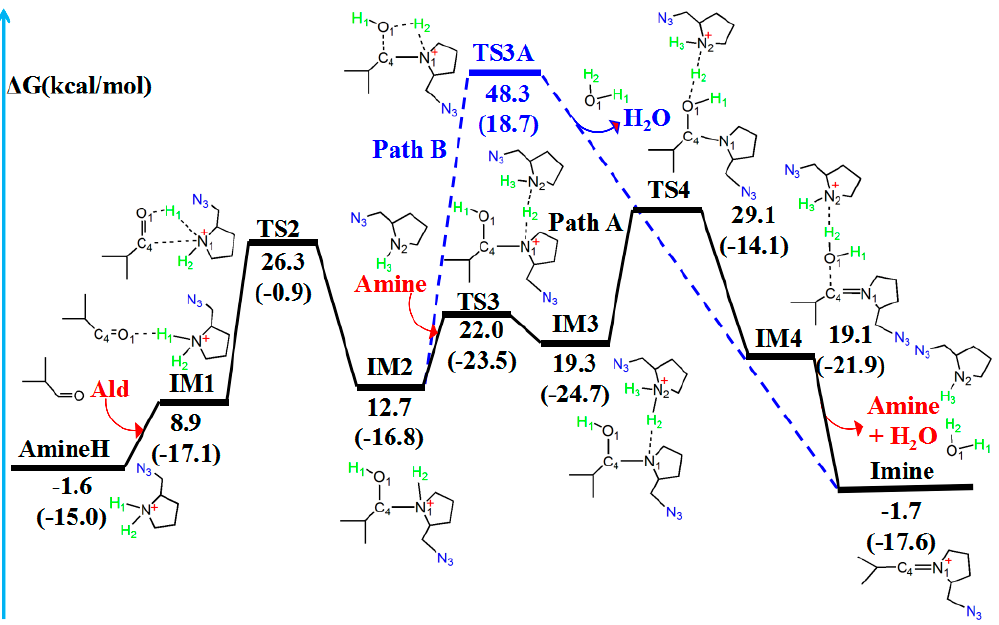
Figure 5. Amine–aldehyde condensation reaction pathway with (Path 1, in black) or without (Path 2, in blue) another amine catalyst. The relative free energy of the reaction pathway involving hydro- gen is provided in kcal/mol. The relative enthalpy is also provided in brackets for reference (in kcal/mol).